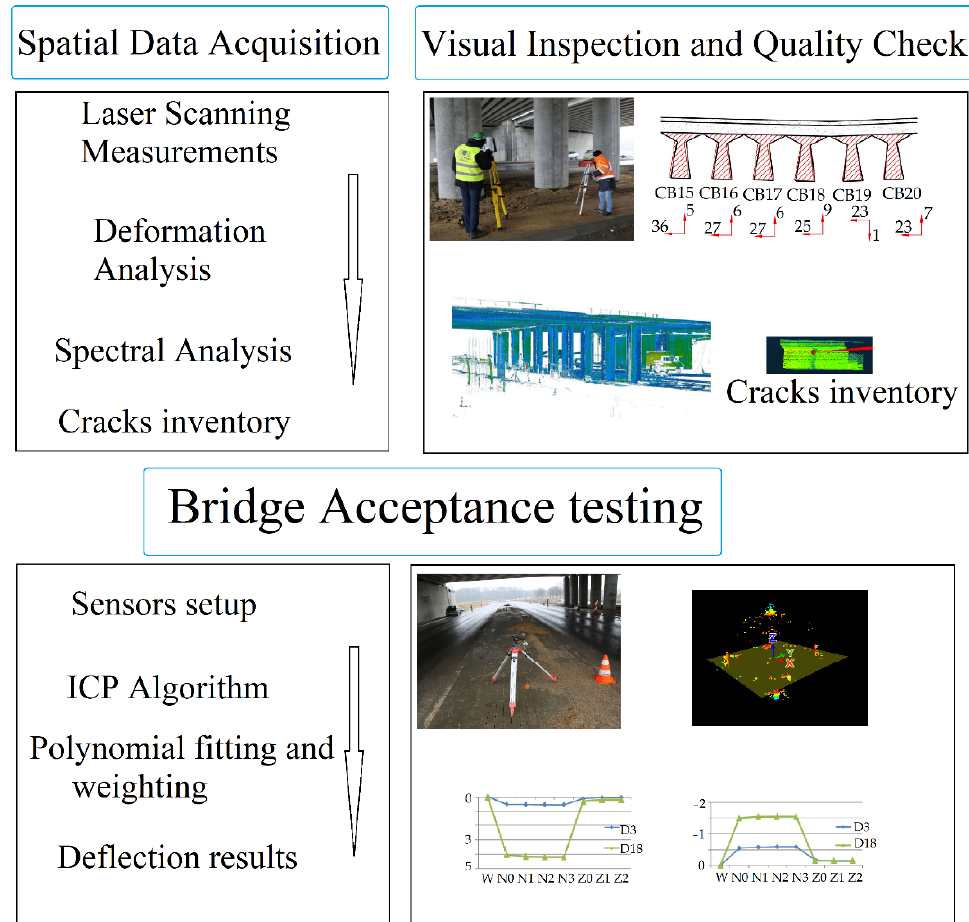
Figure 12. Processing methodology.